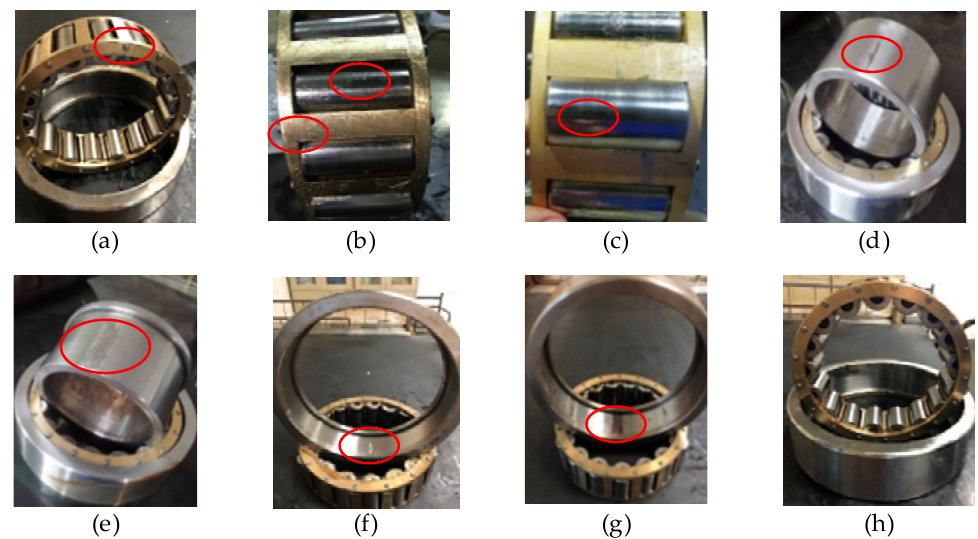
Figure 7. Different types of defective bearings: ( a ) F1; ( b ) F2; ( c ) F3; ( d ) F4; ( e ) F5; ( f ) F6; ( g ) F7; ( h ) F8. The red circle in the figure indicates the location of the defect. Table 1. A detailed description of the bearing data set.